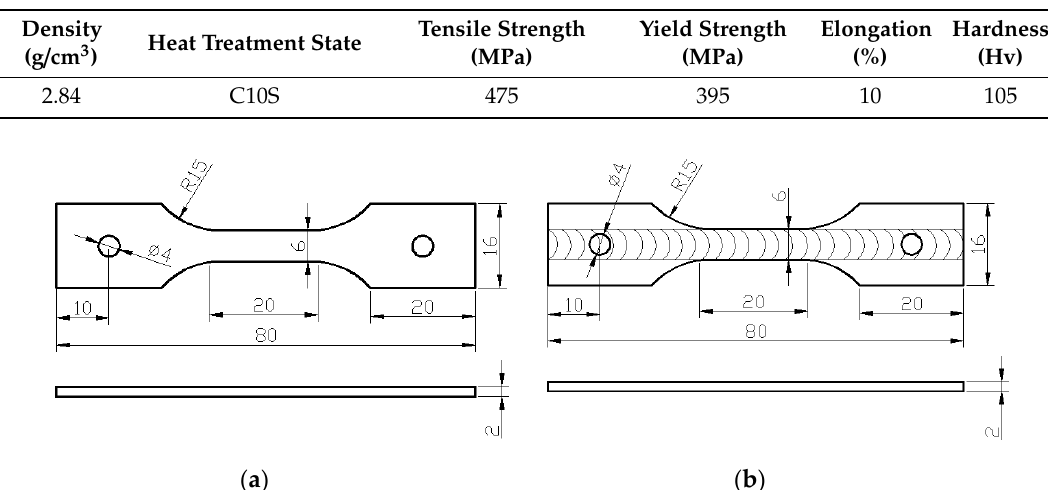
Table 2. Physical and mechanical properties of aluminum alloy 2219.